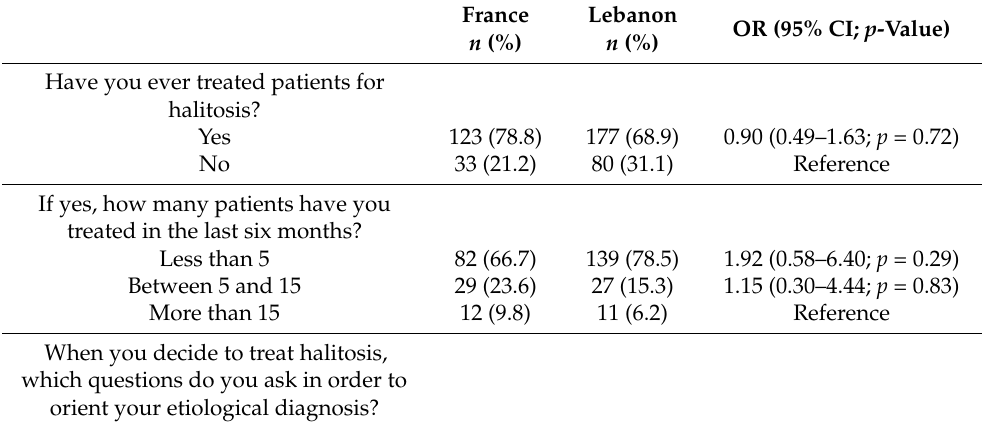
Table 3. Diagnosis and management of halitosis. Difference between LD and FD when adjusted for gender, age, and professional experience. A p < 0.05 was considered significant. (OR: odds ratio, CI: confidence